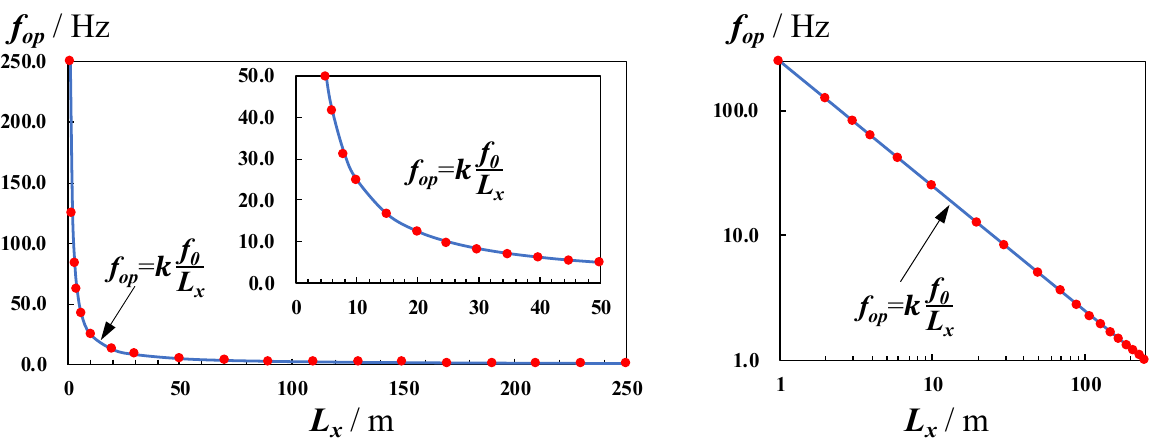
Figure 8. Relation between the optimal pulse frequency f op and pipe length L x when the wave velocity is 1000 m/s. The left drawing is plotted in linear coordinates and the right drawing is plotted in log–log coordinates. Here we take k = 1 as an example to show the curve.